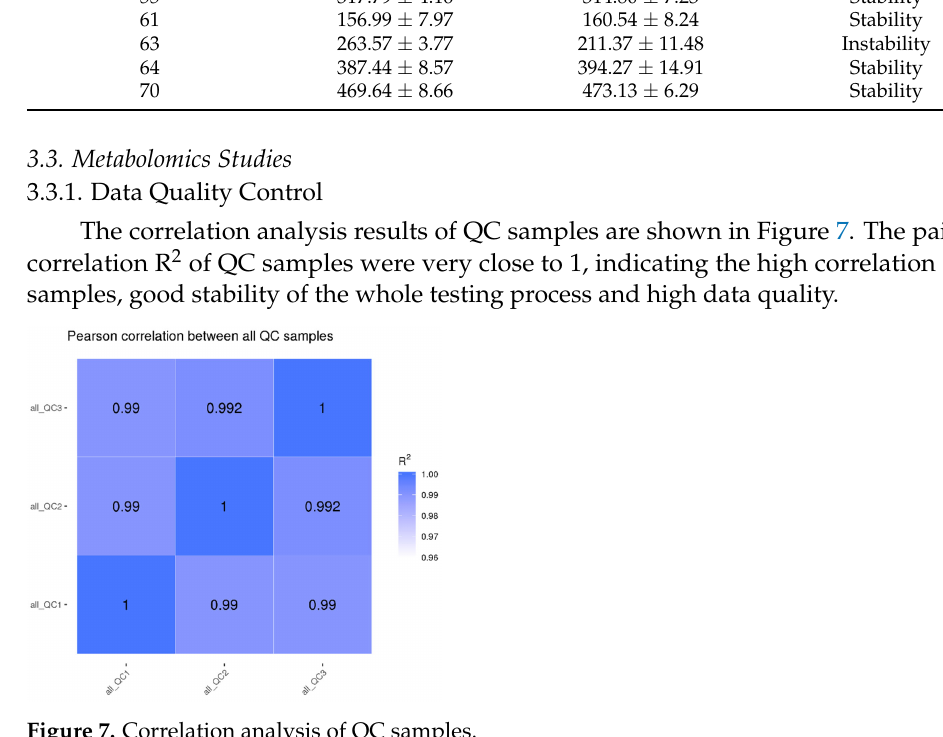
Figure 7. Correlation analysis of QC samples.